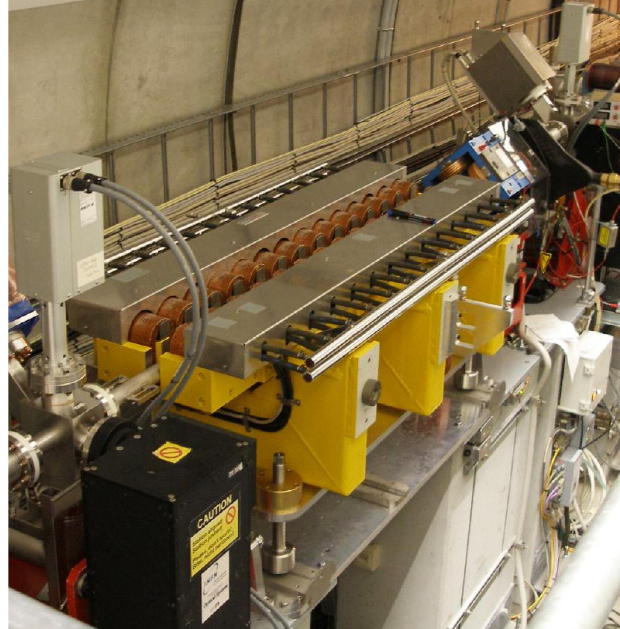
FIG. 2. (Color) The modulator, an electromagnetic undulator in which vertically polarized laser pulses interact with electron bunches, causing a periodic modulation of the electron